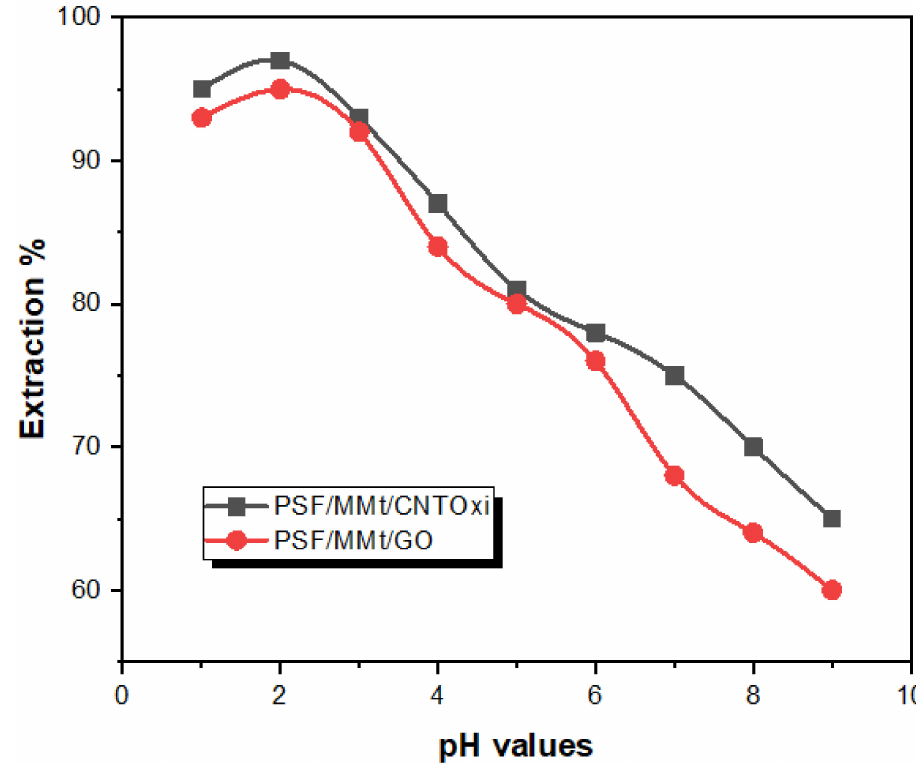
Figure 5. The pH effect on the adsorption of Hg +2 ion (2 mg/L) on 25 mg of PSF/MMt/GO and PSF/MMt/CNTOxi respectively at 25 ◦ C.